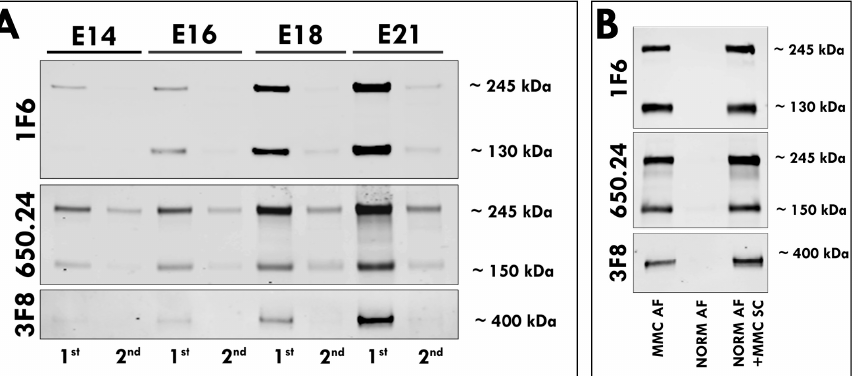
Figure 3. ( A ) Spinal cords isolated from MMC fetuses at E14, E16, E18, and E21 were sequentially extracted with detergent-free buffer (first extract), followed by detergent-containing buffer (second extract), and equal amounts of extracted total protein were digested with ChABC and subjected to Western blotting analysis with 1F6, 650.24, or 3F8 antibodies. Representative Western blot demon- strates that the vast majority of neurocan and phosphacan was detected in the first extract compared with the second extract at all gestational ages. ( B ) Equal volumes of AF samples from E21 MMC fetuses (MMC AF), AF samples from normal age-matched controls (NORM AF), and AF samples following incubation of spinal cords isolated from E21 MMC fetuses in normal age-matched AF (NORM AF + MMC SC) were digested with ChABC and subjected to Western blotting analysis with 1F6, 650.24, or 3F8 antibodies. Western blot demonstrates the presence of the full-length and proteolytically cleaved N-terminal and C-terminal fragments of neurocan and phosphacan in the AF samples following incubation of spinal cords isolated from MMC fetuses in normal AF, which does not contain these proteins. Data represent spinal cord extracts from at least two independent sets of spinal cord tissue samples per age group.